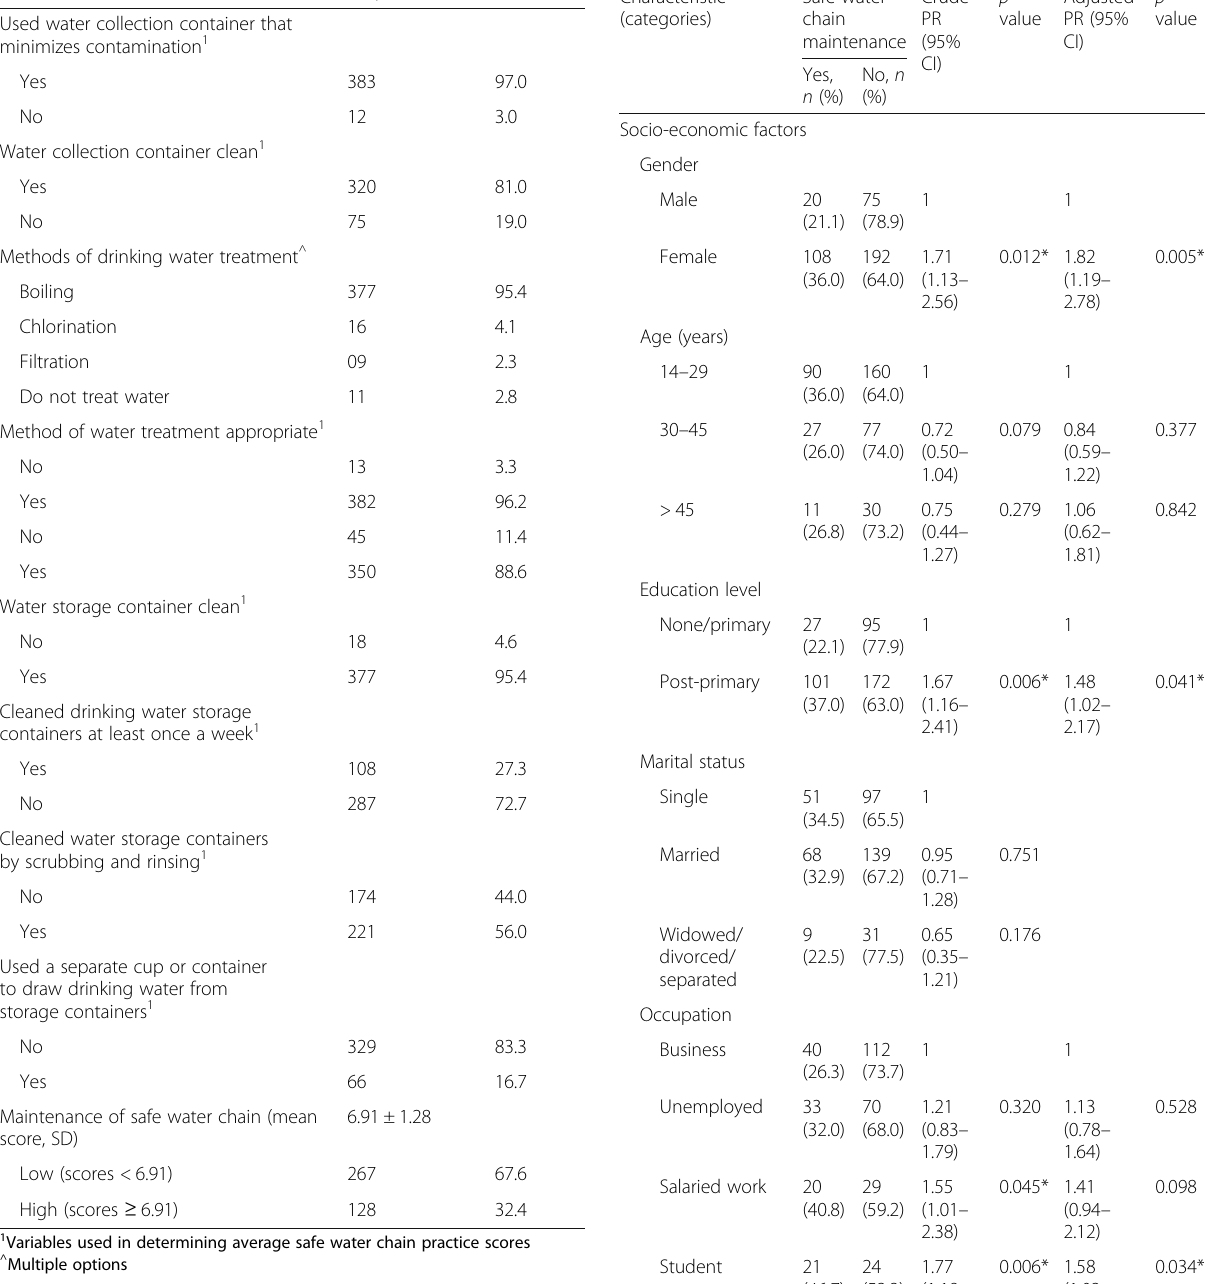
Table 6 Factors associated with maintenance of the safe water chain Percentage 395) Characteristic